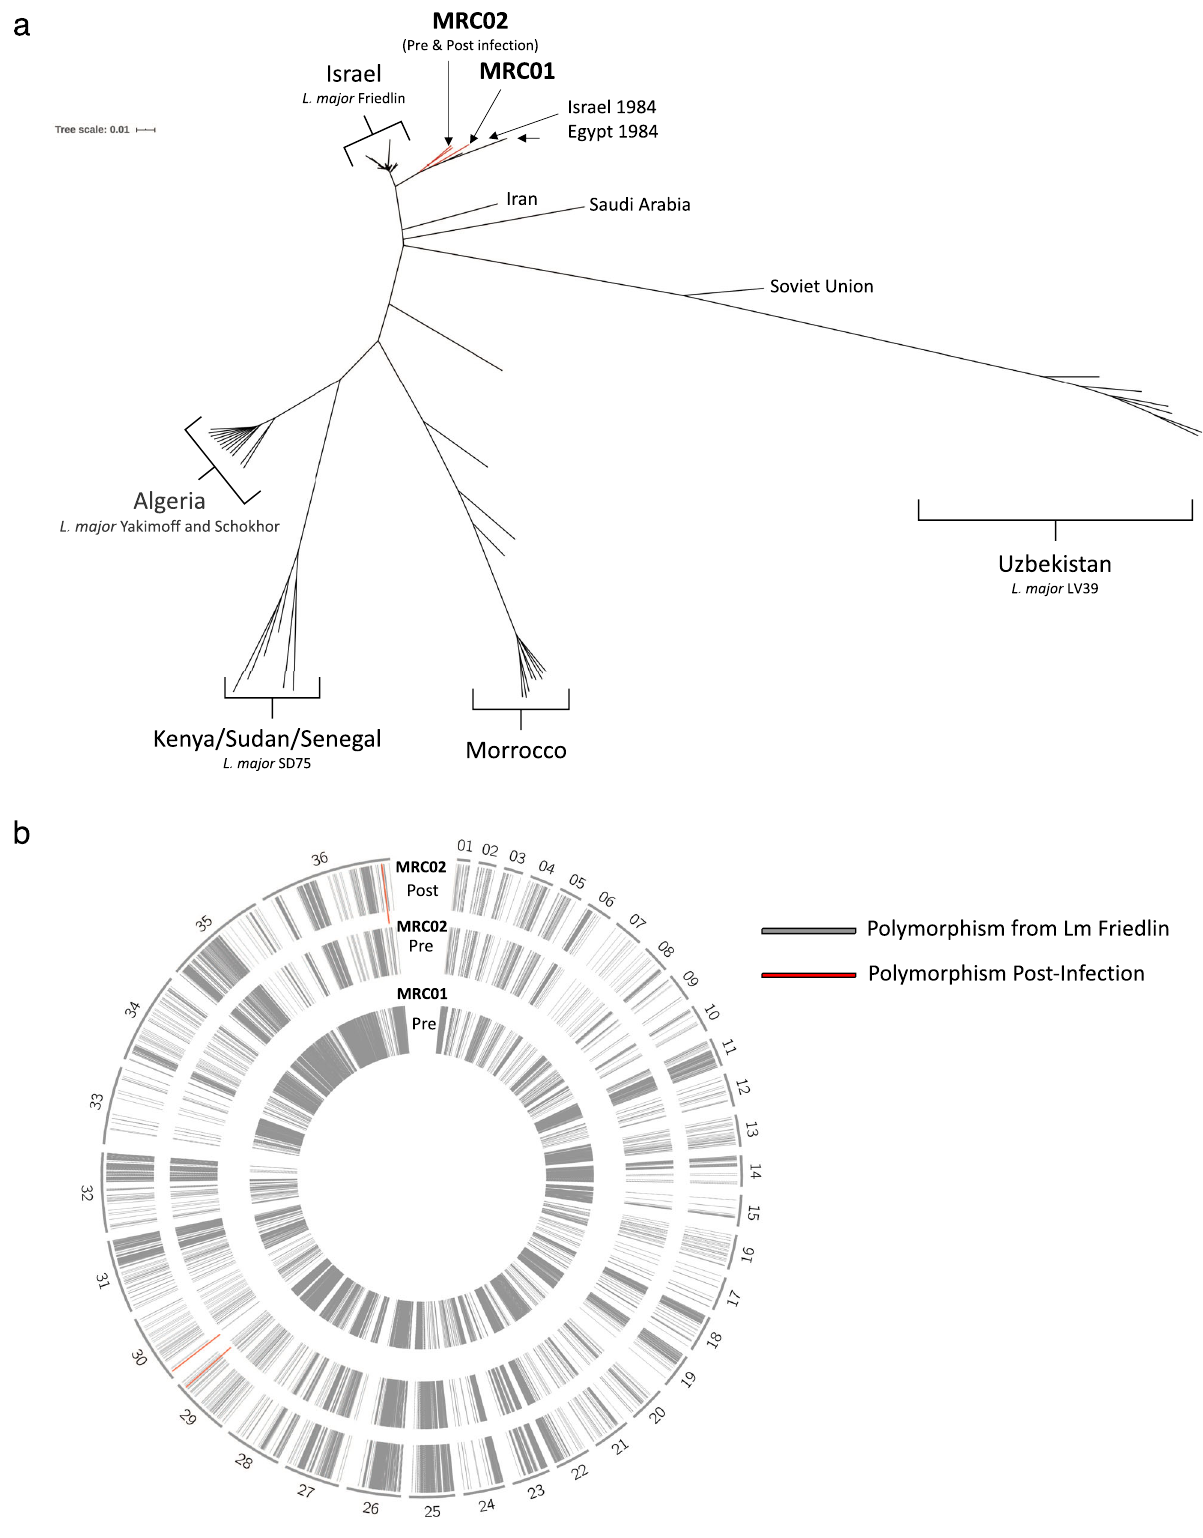
Fig. 2 Characterisation of L. major MRC-01 and L. major MRC-02 by whole-genome sequencing. a Phylogeny tree developed using all available whole- genome sequences for L. major from different parts of the world and the location of the L. major MRC-01 and L. major MRC-02 strains. The phylogeny tree was constructed using the L. major Friedlin strain as the reference strain. b Alignment map for L. major chromosomes 1 – 36. Grey bars represent location of homozygous single nucleotide polymorphism (SNPs) and indels where there are differences between L. major MRC-01, L. major MRC-02 and L. major MRC- 02 after passage infection in BALB/c mice) and the reference strain L. major Friedlin. Red bars indicate chromosomal location of SNPs/indels differences between L. major MRC-02 (pre-infection) and the L. major MRC-02